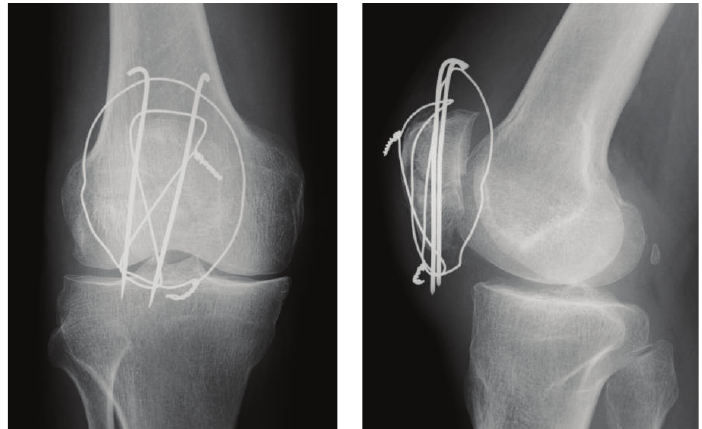
Figure 1: Plain radiographs after the primary surgery.